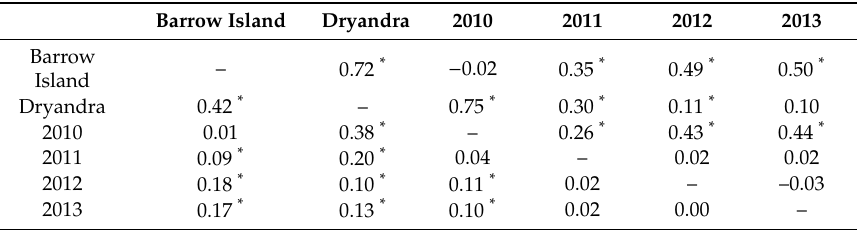
Table 2. Pairwise F ST and φ ST values between the source populations and samples collected from the translocated population (Matuwa) between 2010 and 2013, based on microsatellite (below diagonal) and mitochondrial DNA (mtDNA) data (above diagonal). Significant F ST values after correction for multiple comparisons and φ ST values are denoted with an